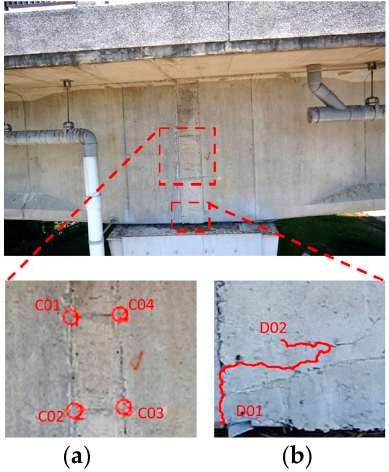
( b ) Figure 14. Bridge inspections performed by the self-assembled UAV: ( a ) operation on the side of the Wuling Bridge; ( b ) operation at the bottom of the Wuling Bridge. 3.2. Outdoor Bridge Inspection Tests (1)